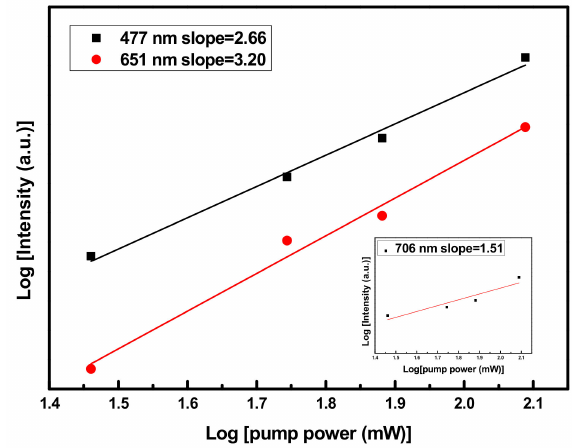
Figure 3. The log-log plot of the emission intensity centered around 477, 651, and 706 nm versus the pump power of Tm 3+ /Yb 3+ co-doped LNT glasses with y = 0.03.